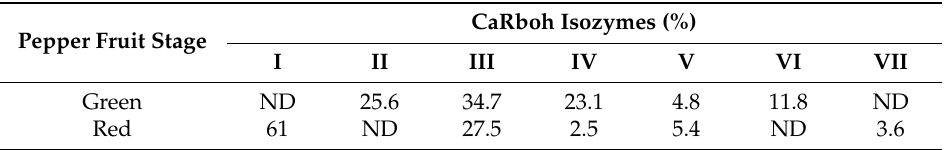
Table 1. Identification (I to VII) and relative abundance (%) of the respiratory burst oxidase homolog (CaRboh) isozymes detected in green and red pepper ( Capsicum annuum L.) fruits by the NBT